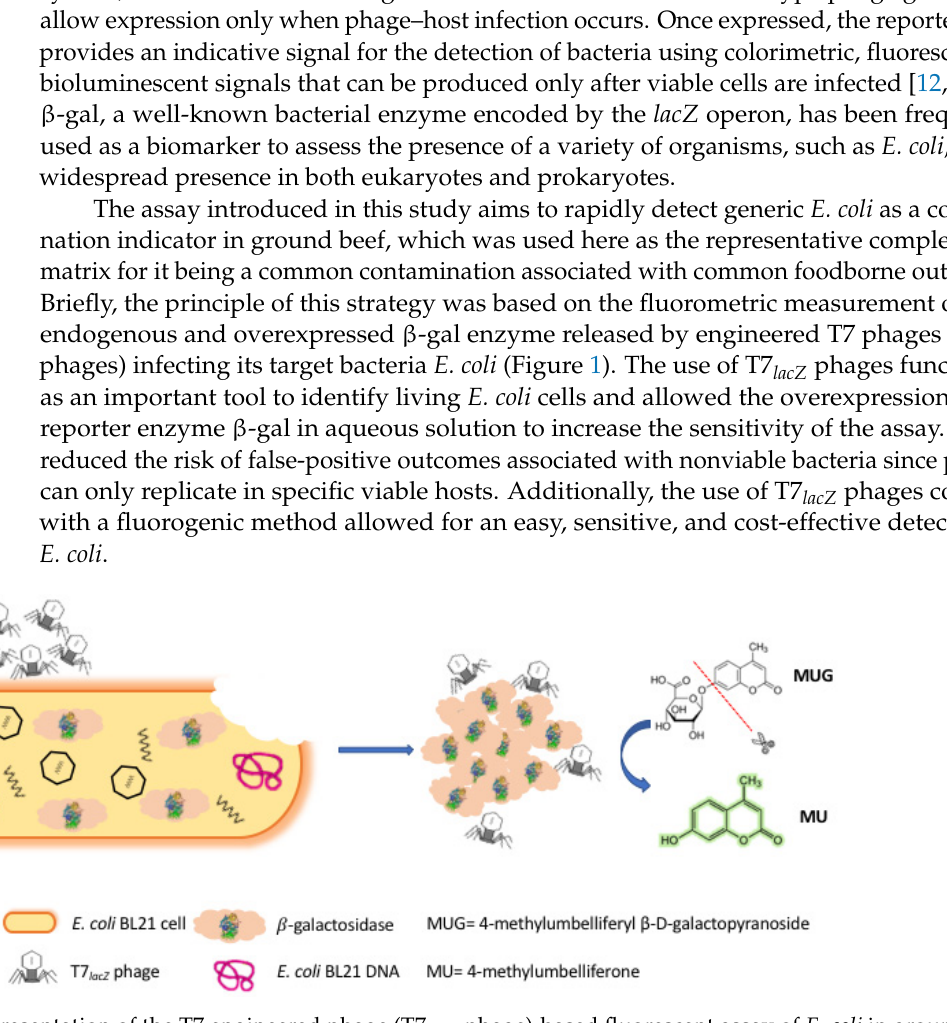
Figure 1. Schematic representation of the T7 engineered phage (T7 lacZ phage)-based fluorescent assay of E. coli in ground beef. T7 phages were engineered to overexpress the reporter enzyme β -gal. Phage infection induces the production and release of intracellular and phage-induced β -gal. The substrate 4-methylumbelliferyl β -D-galactopyranoside (MUG) was metabolized by β -gal to generate the fluorescent product 4-methylumbelliferone (MU).